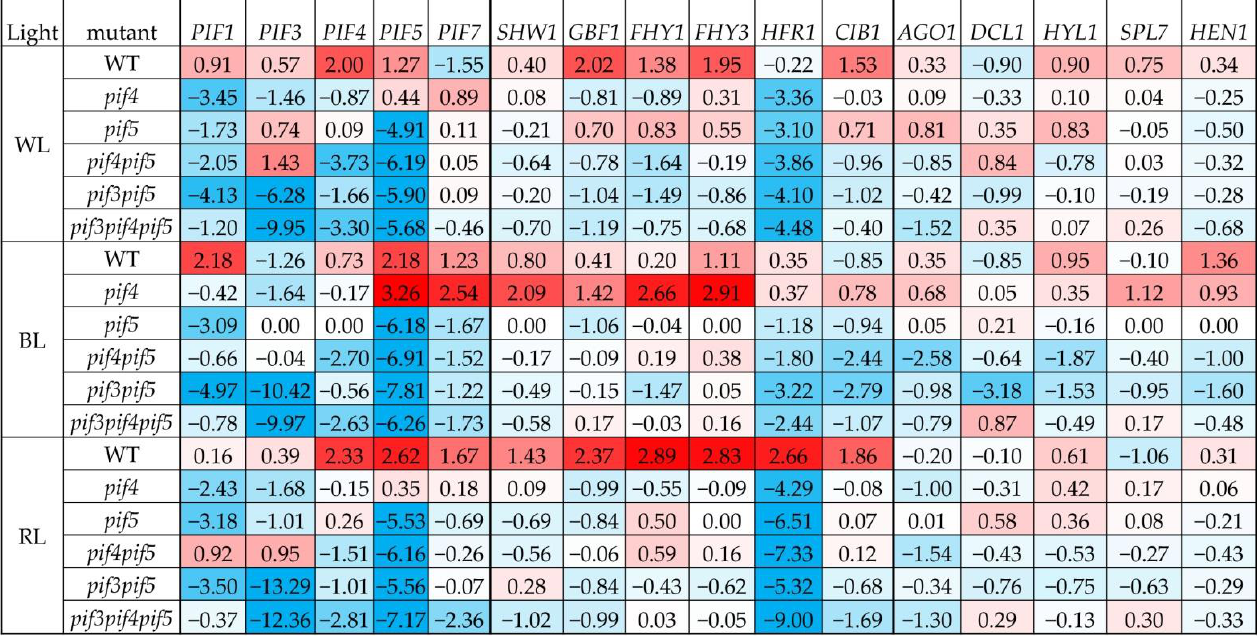
Figure 3. Effect of light with different spectra on the expression of transcription factor genes, light signalling genes, and microRNA processing genes in wild-type and pif mutant four-week-old A. thaliana plants. Log 2 data are presented. Changes were considered significant if the expression was above or below one ( p < 0.05; n = 3). The transcript levels were normalized to the expression of the Actin1 gene.